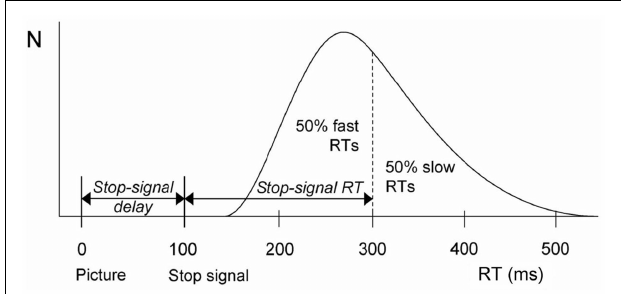
FIGURE 1 | Calculation of stop-signal RT (SSRT) according to the race model (Logan and Cowan, 1984). The black curve depicts the distribution of RTs on go trials (i.e., trials without a stop-change signal) representing the finishing times of the go process. Assuming independence of the go and stop processes, the finishing time of the stop process bisects the go RT distribution. Given that the response could not be stopped on nth percent of all stop-change trials (here at 50%), SSRT (200ms) is calculated by subtracting the mean stop-change signal delay (100ms) from the 50th percentile of go RT